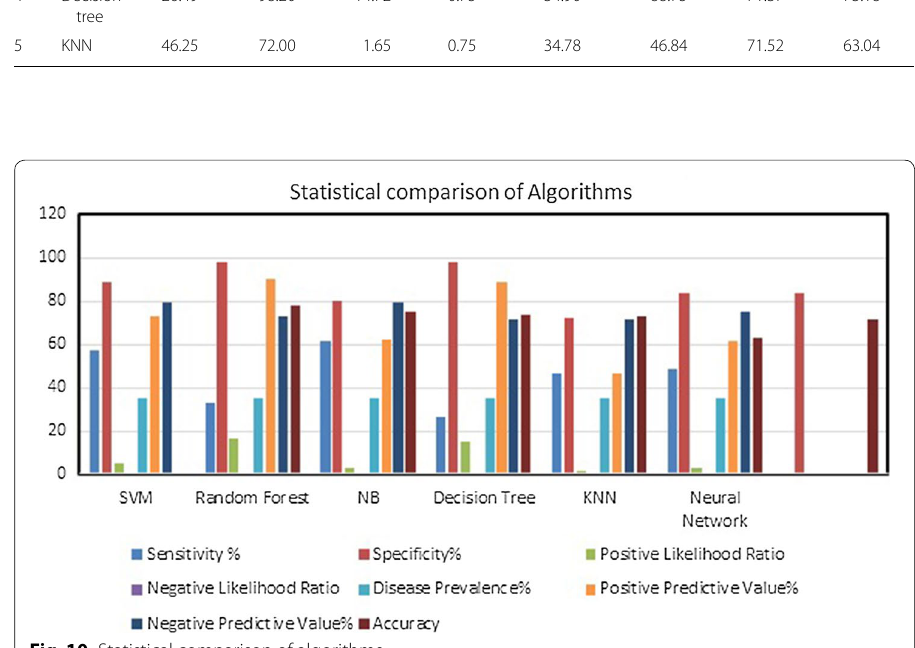
Figure 11: the results represents improvised performance metrics of classification techniques.